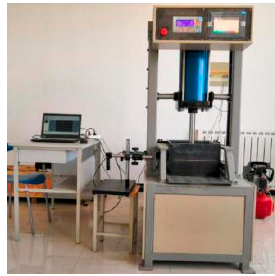
Figure 2. The pull-out test equipment.